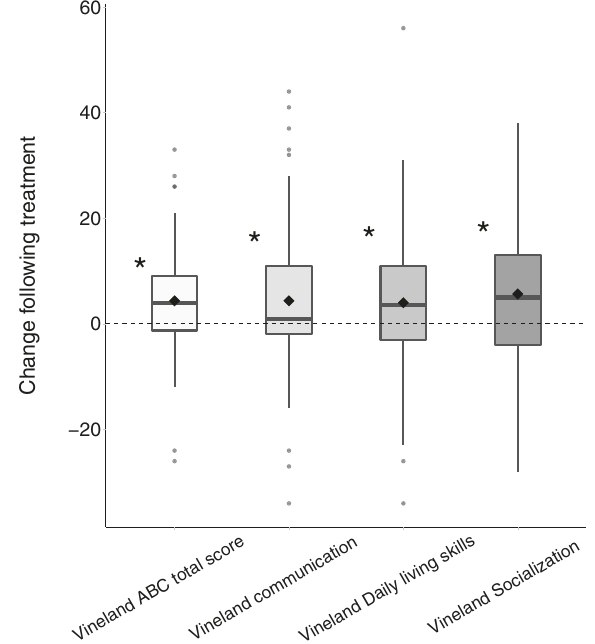
Fig. 4 Change in Vineland scores pre/post treatment. Vineland total score, communication sub-scale, socialization sub-scale, daily living skills sub-scale. Asterisk: signi fi cant change ( p < 0.05, rando- mization test). Black diamond: mean. Bold line: